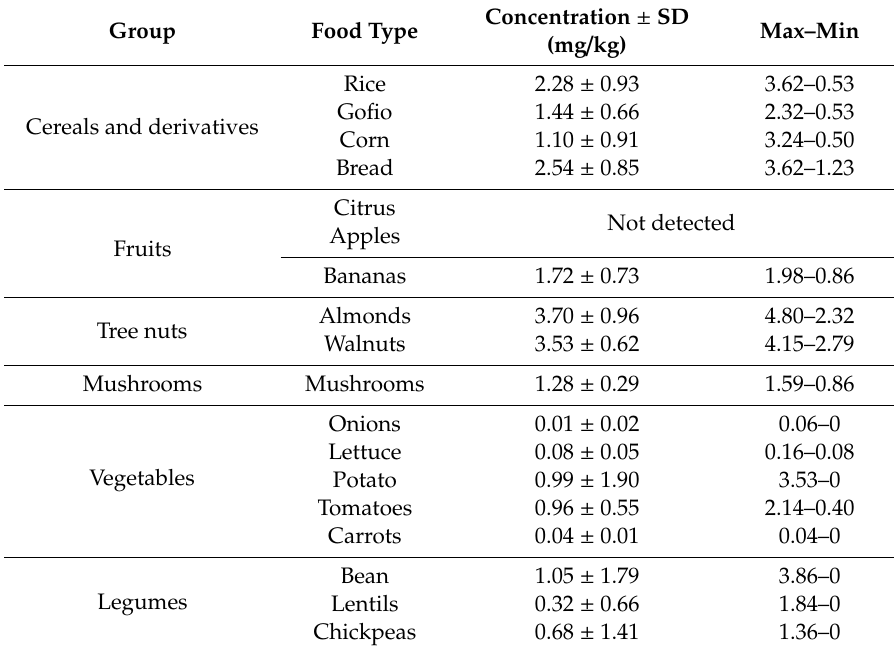
Table 2. Fluoride concentration, standard deviation, and maximum and minimum values found in the analyzed